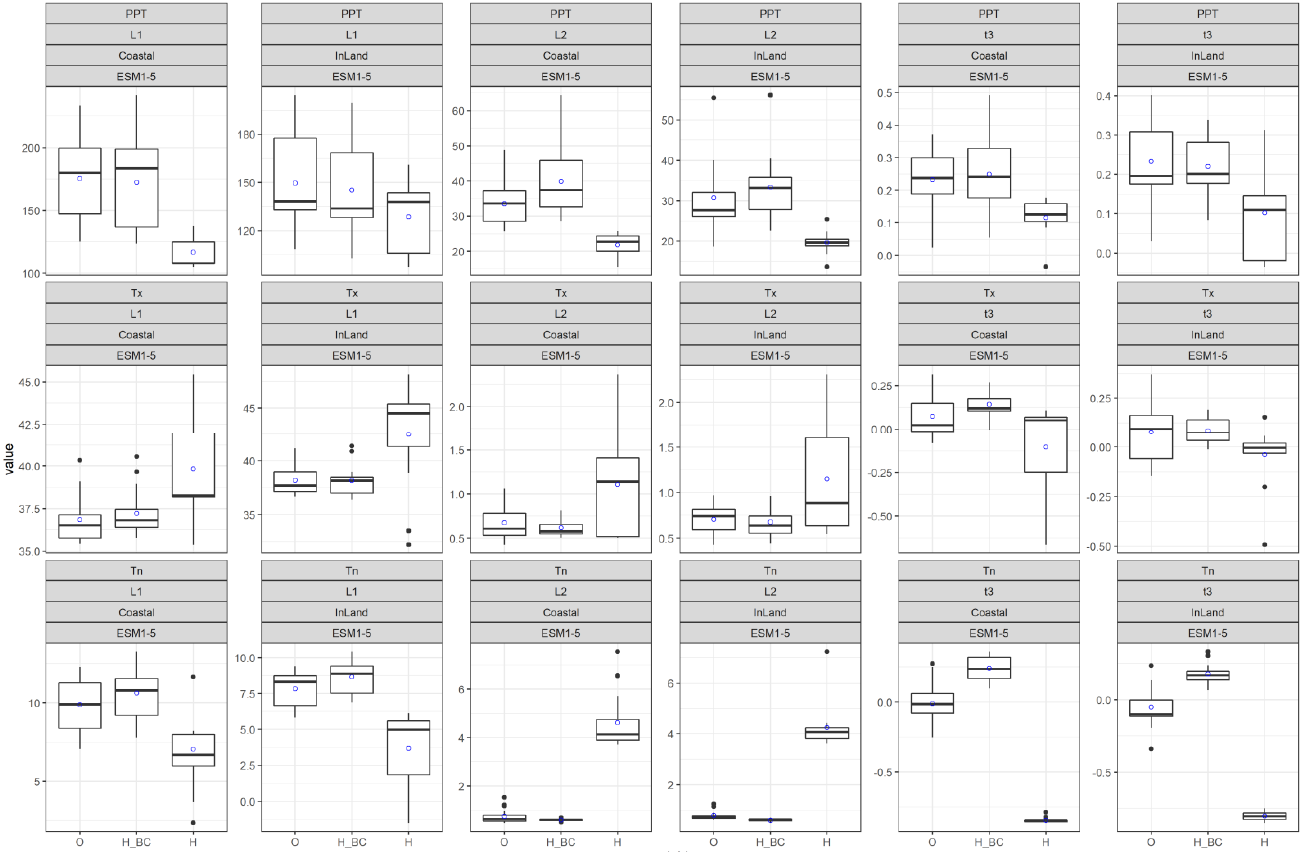
Figure 3. Performance of bias-corrected data. Box plots of fitted L − moments (1st L − moment (L1), 2nd L − moment (L2) and L − skewness (t3)) at observed and simulated historic conditions ( data from GCM model, ESM1 − 5, is used for demonstration) for PPT, Tx and Tn for both coastal and inland region. ‘O’ represents estimate of L − moments based on observed data while ‘H_BC’ and ‘H’ represent L-moments estimate, respectively based on bias-corrected historical and uncorrected historical simulated data. The “blue circle” on each box plot represents the average value.